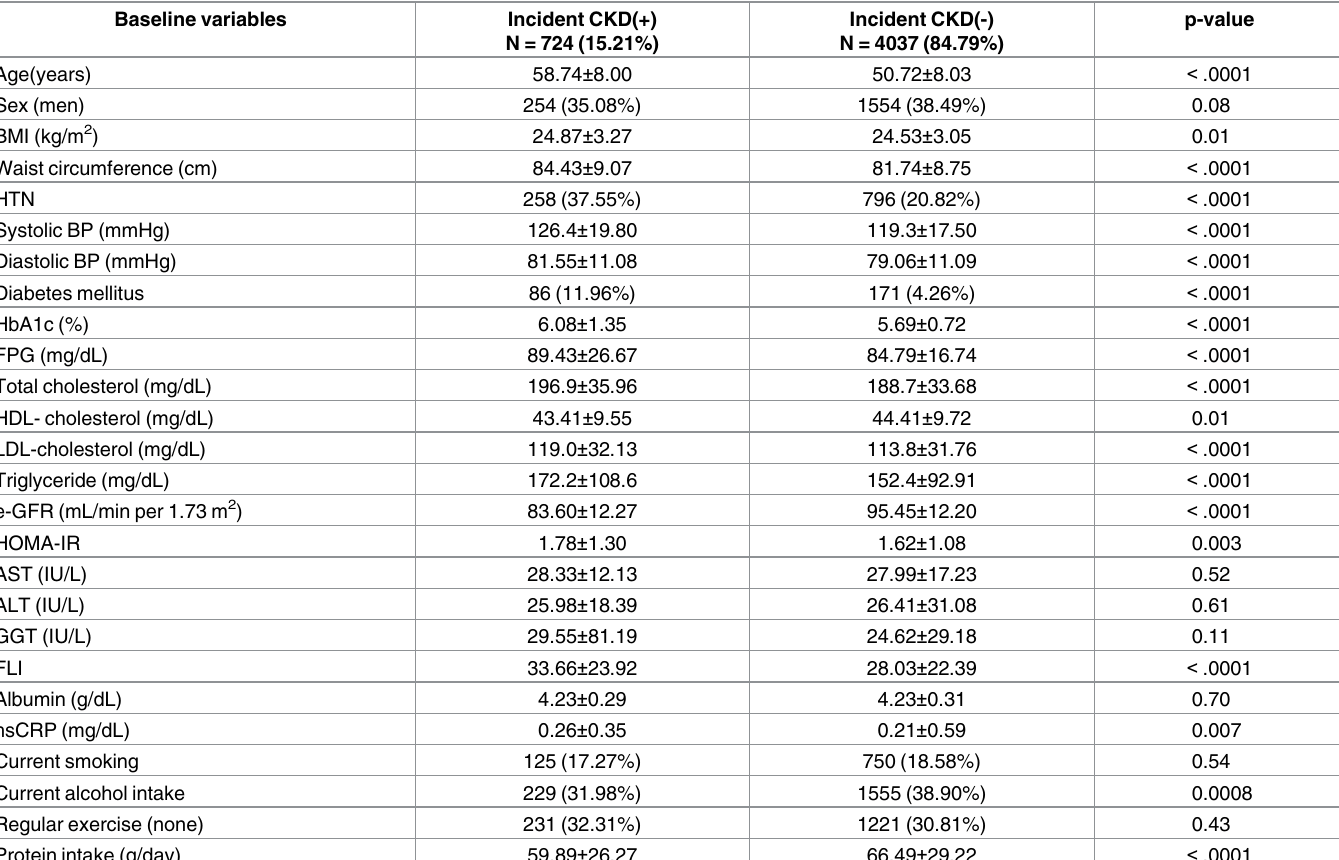
Table 1. Baseline characteristics according to incident